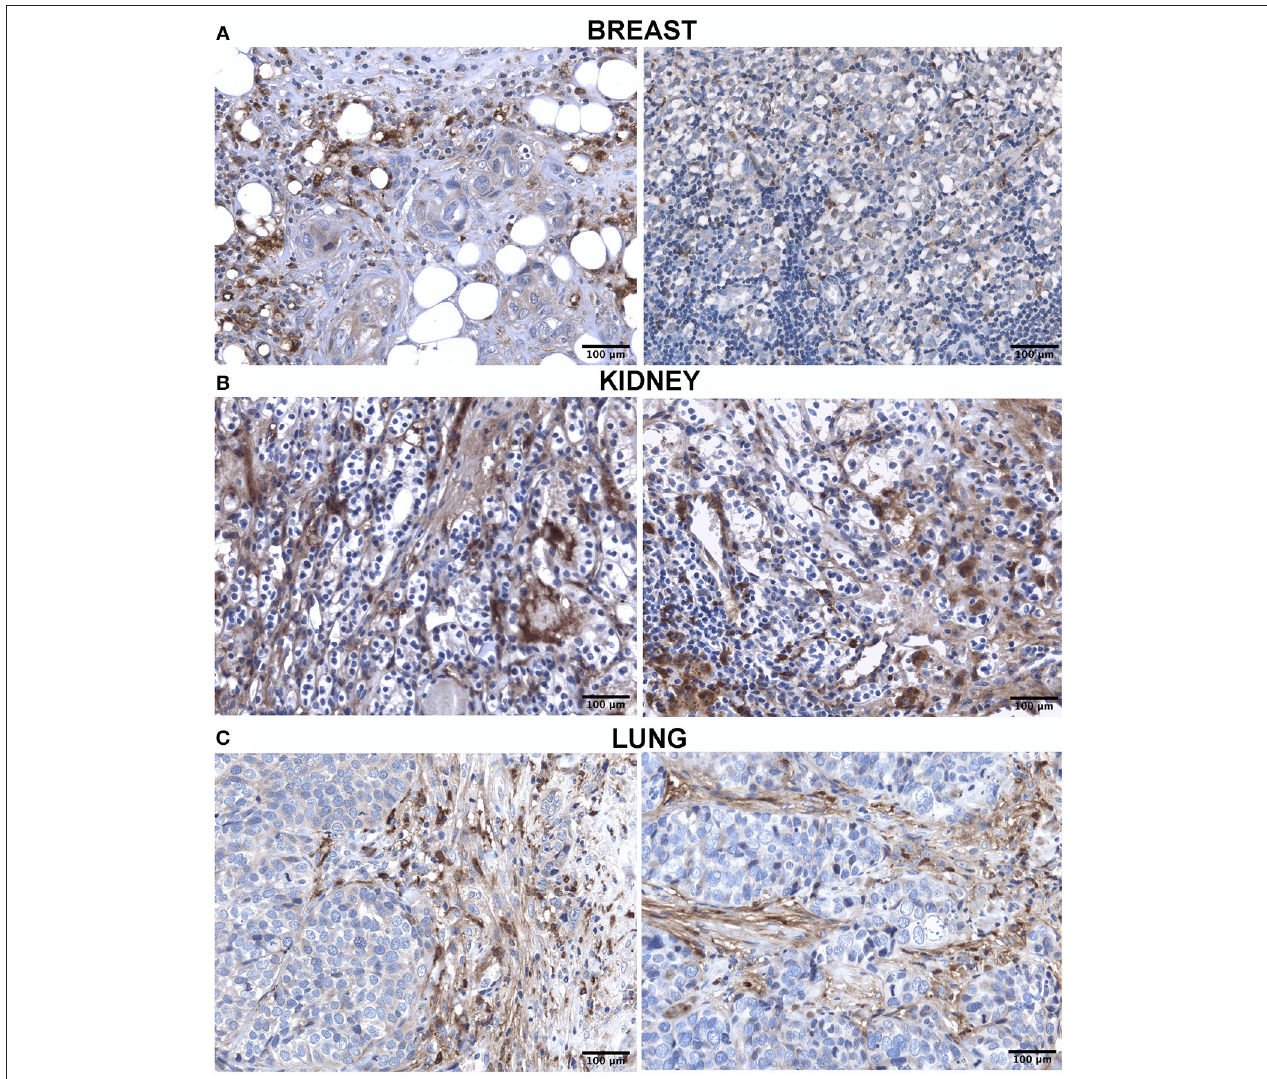
FIGURE 2 | Immunohistochemistry analysis for C1q in breast (A) , kidney (B) and lung carcinoma (C) . Representative microphotographs showing expression of C1q in different carcinoma. The expression of C1q in carcinoma was observed in all tissues with differential distribution in the TME, as described in the result section. DAB (brown) chromogen was used to visualize the binding of anti-human C1q antibodies; scale bars, 50 µ